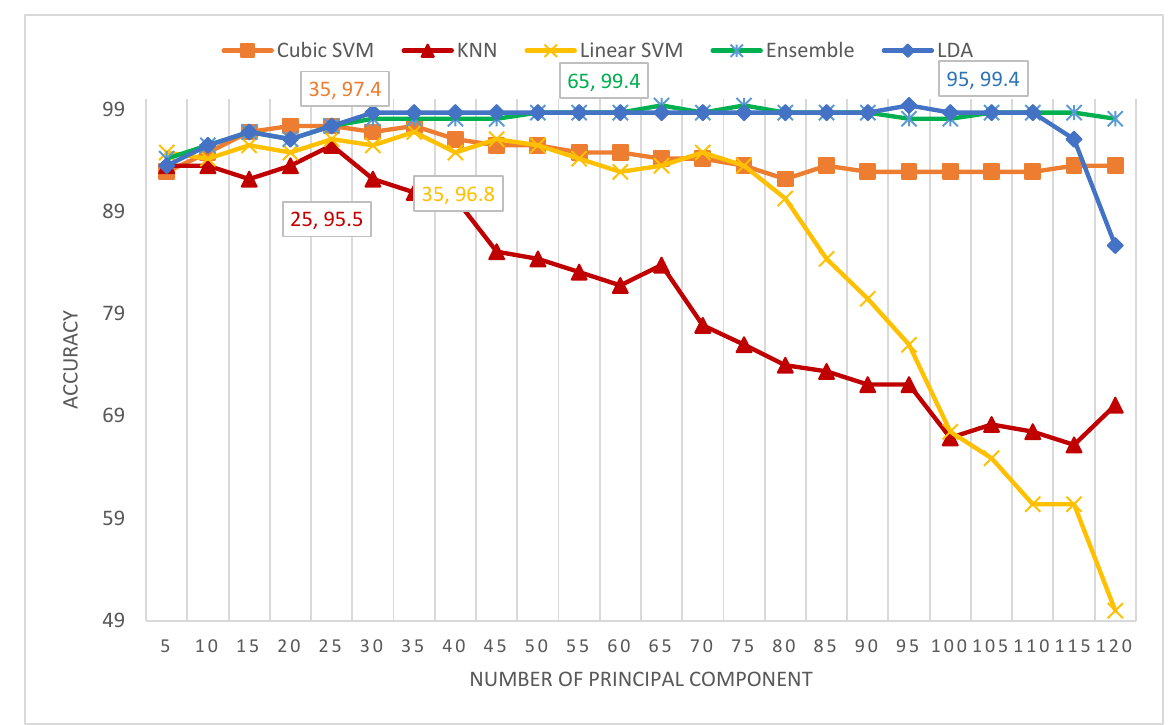
Figure 8. The number of principal components versus the classification accuracies attained for the five classifiers of MB-AI-His-CADx.